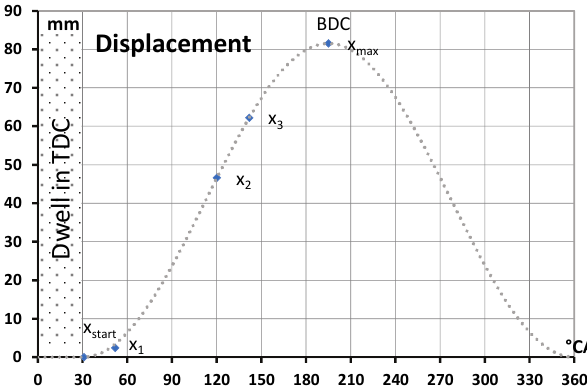
Fig. 4. Characteristic points of displacement (blue points) against the background of the base function (gray